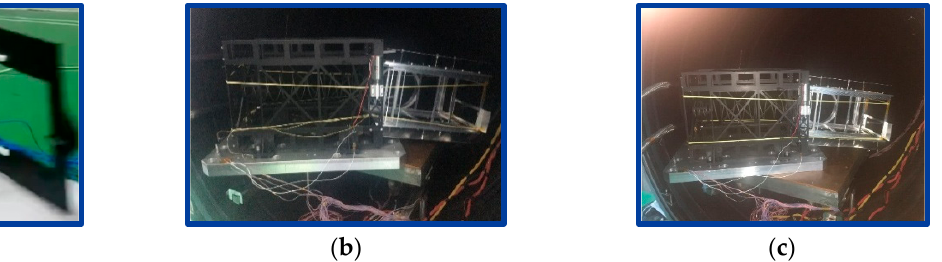
Figure 17. Separation test. ( a ) room temperature; ( b ) vacuum high-temperature; ( c ) vacuum low-temperature.